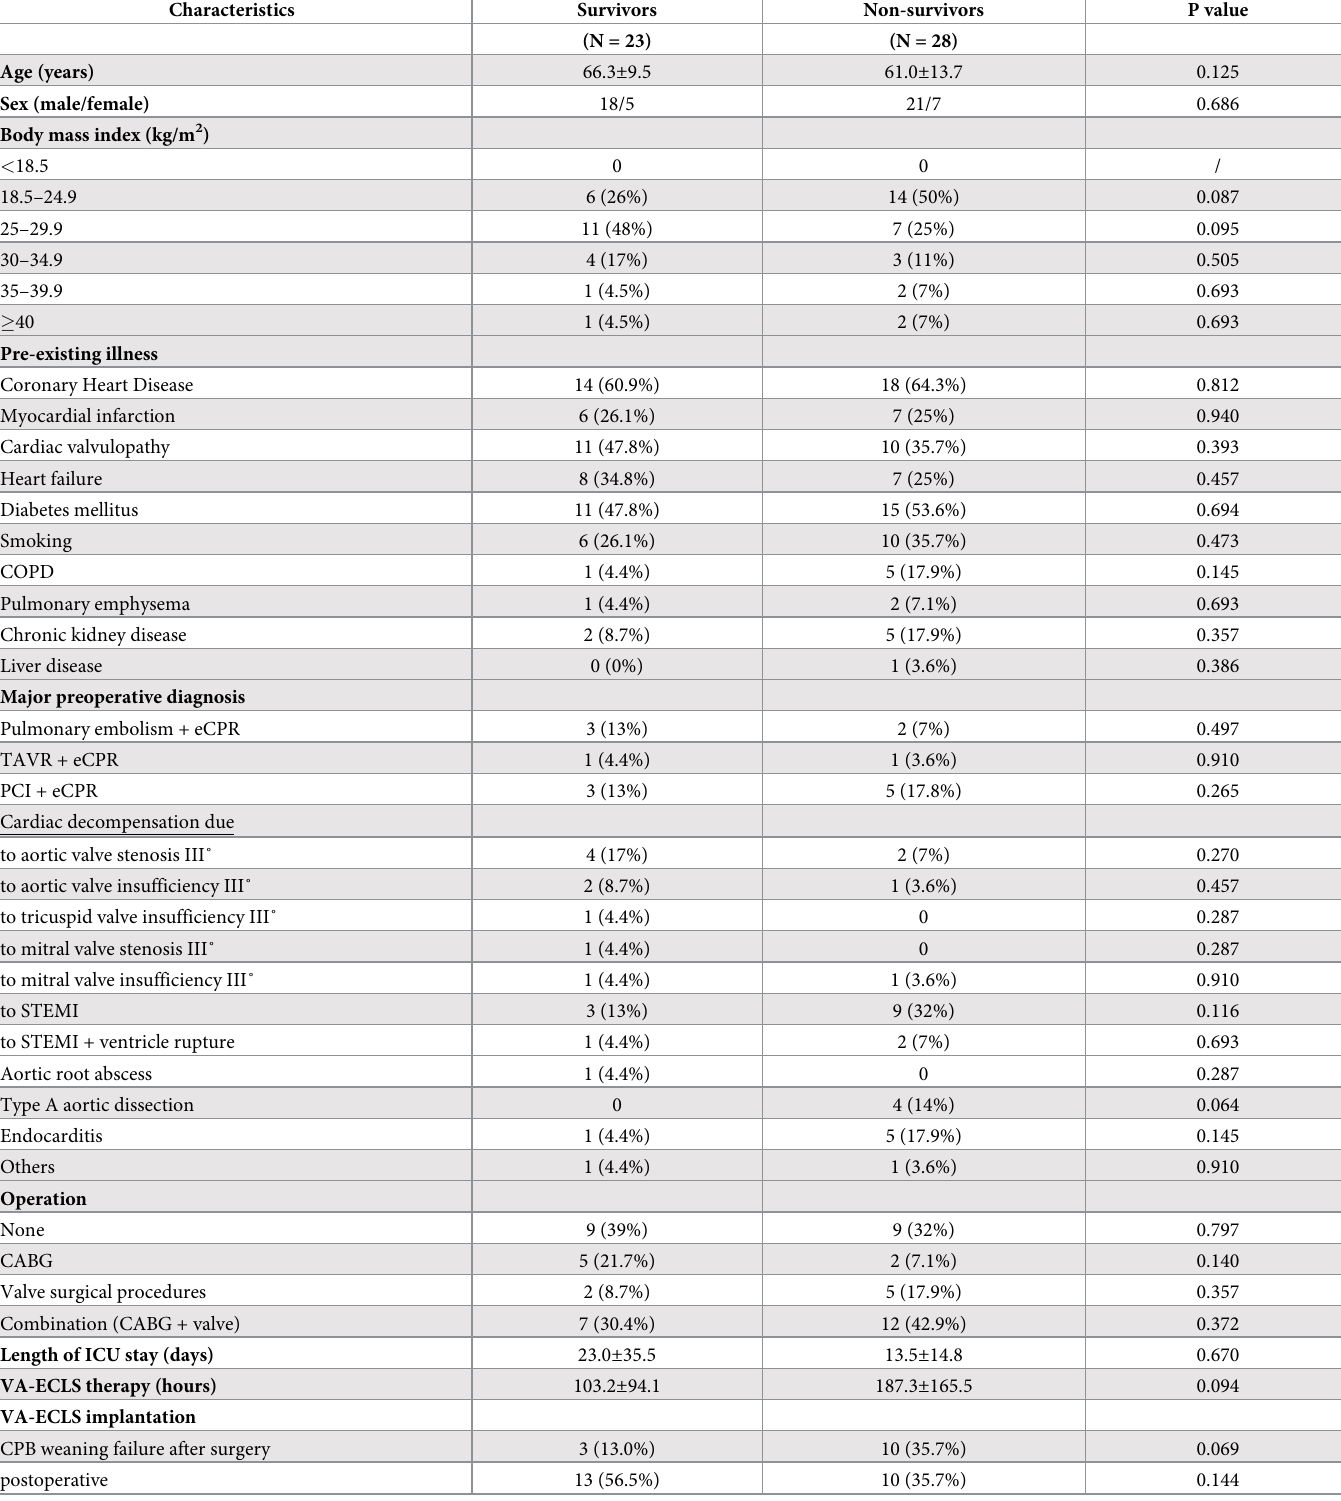
Table 1. Patient’s